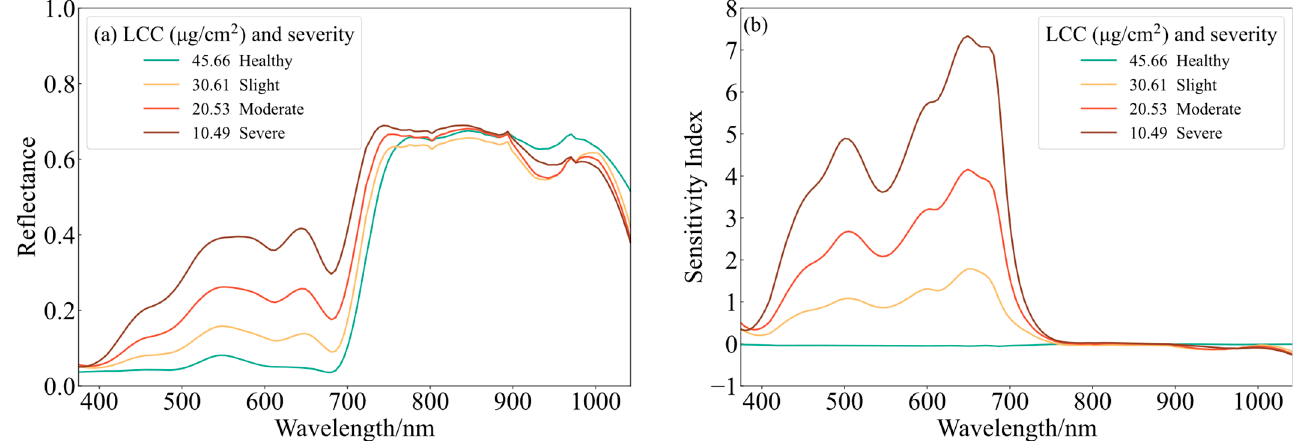
Figure 5. ( a ) Spectral re fl ectance and ( b ) SI of leaves with di ff erent